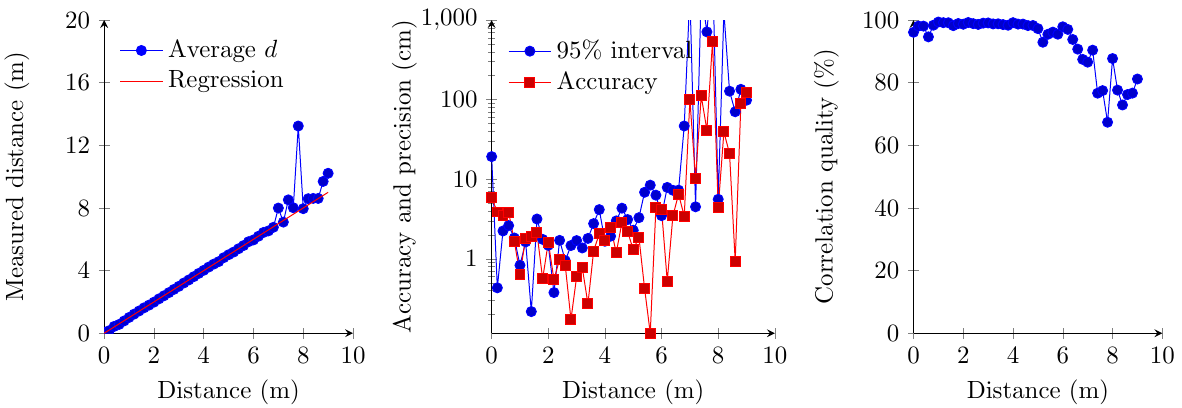
Figure 14. Linear regression of the measured distances ( left ); accuracy and the 95% confidence interval ( middle ); and correlation quality ( right